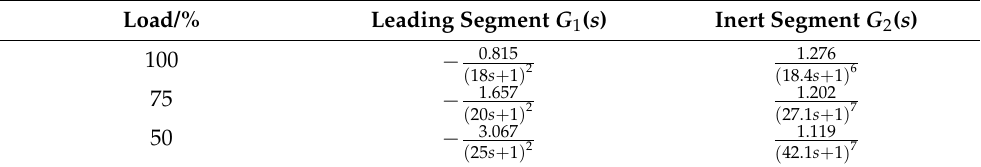
Table 1. Transfer function of the SST system under typical operating